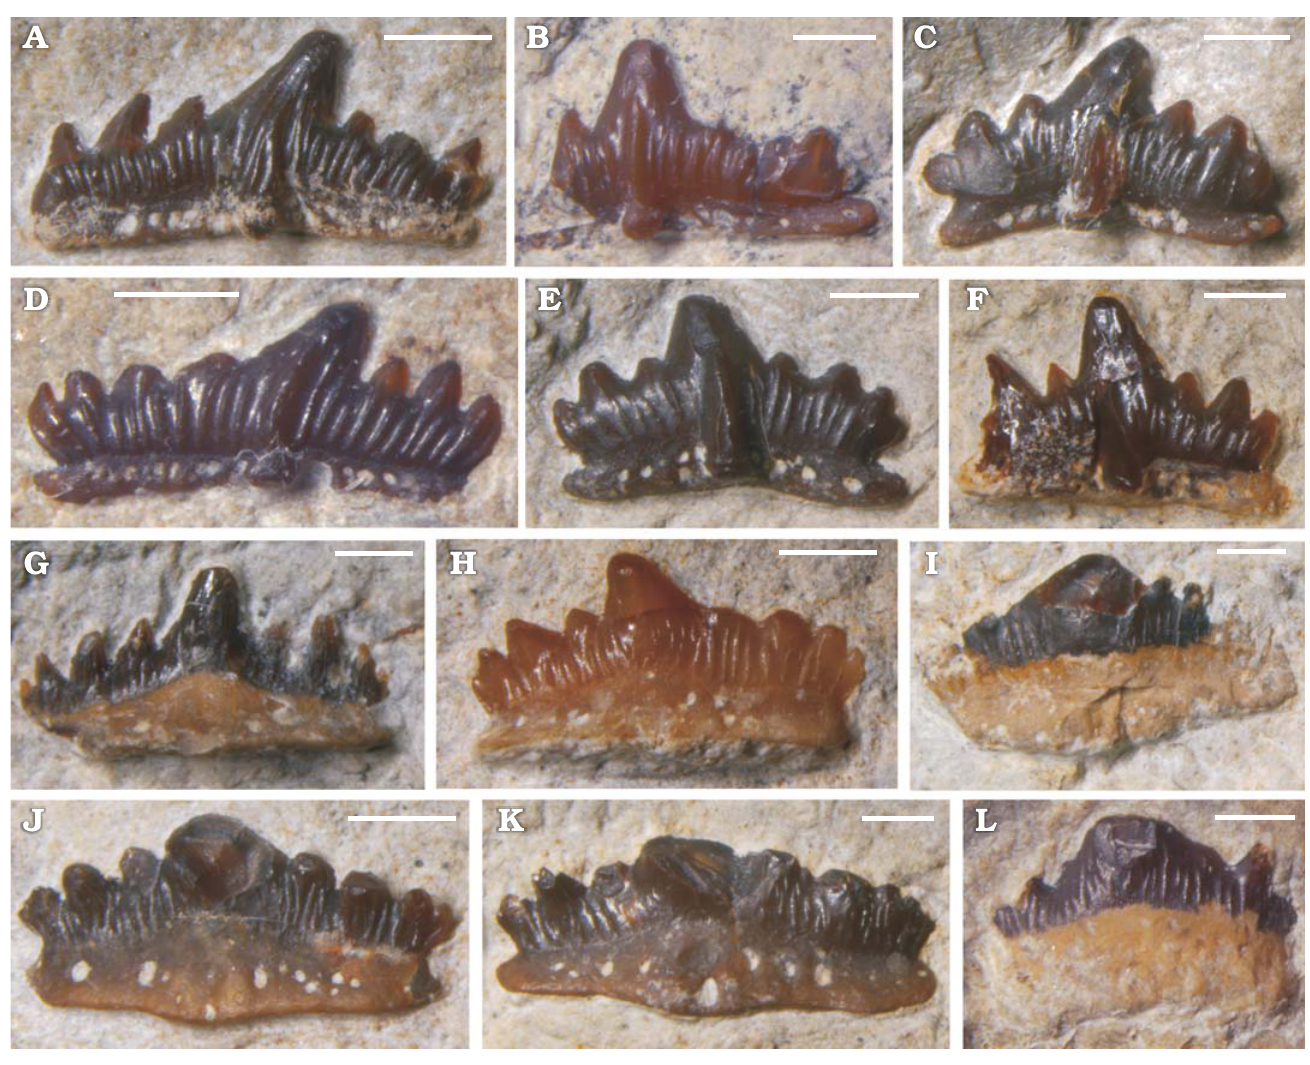
Fig. 3. Teeth of the euselachian shark Artiodus prominens Ivanov and Duffin gen. et sp. nov. from the Artinskian (Early Permian) of Krasnoufimskie Klyuchiki quarry (Middle Urals, Russia). A . NHMUK PV P65426. B . NHMUK PV P65452. C . NHMUK PV P65427. D . NHMUK PV P65450. E . NHMUK PV P65451. F . NHMUK PV P65455. G . NHMUK PV P65457. H . NHMUK PV P65456. I . NHMUK PV P65458. J . NHMUK PV P65454. K . NHMUK PV P65453. L . NHMUK PV P65459. A–F, labial views; G–L, lingual views. Scale bars 1